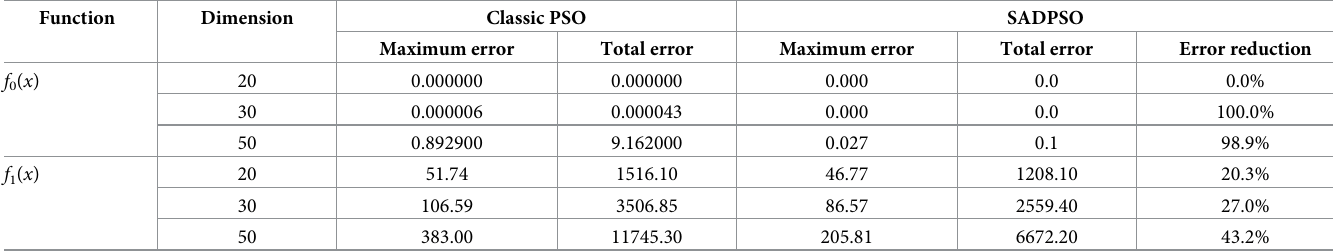
Table 1. Comparison of classic particle swarm optimization with statistical adaptive dynamic particle swarm optimization results. Function